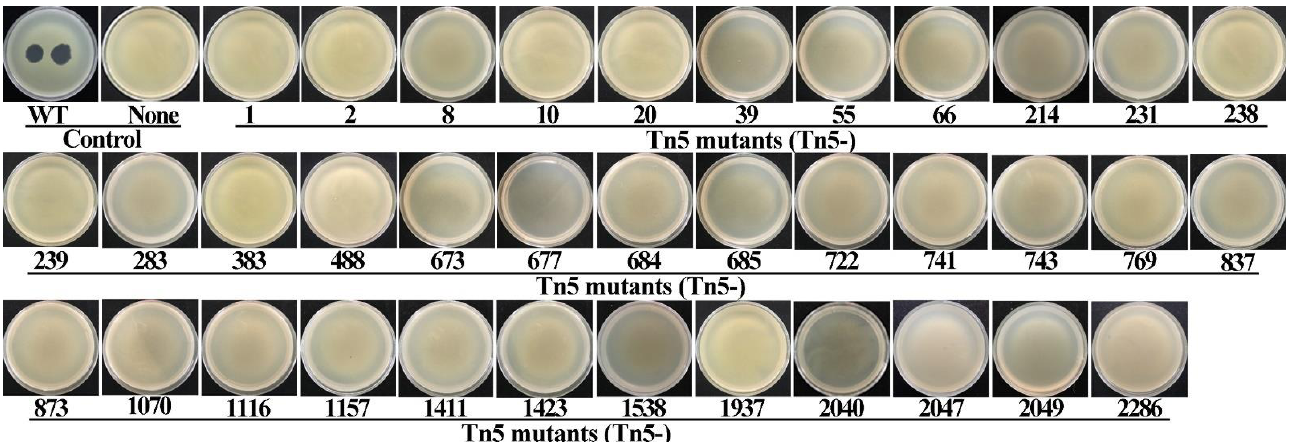
Figure 2. Screening of phage-resistant mutants by evaluating the infection of phage X2 to the constructed 4524 Tn5 mutants of Xanthomonas oryzae pv. oryzae strain C2. WT: Wild type (+phage); None: wild type (-phage); Tn5-(number): 36 phage-resistant Tn5 mutants (no plaques).